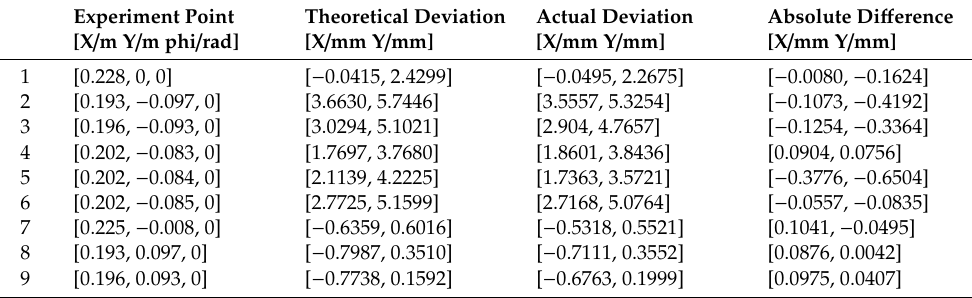
Table 3. Comparison of theoretical and actual deviation